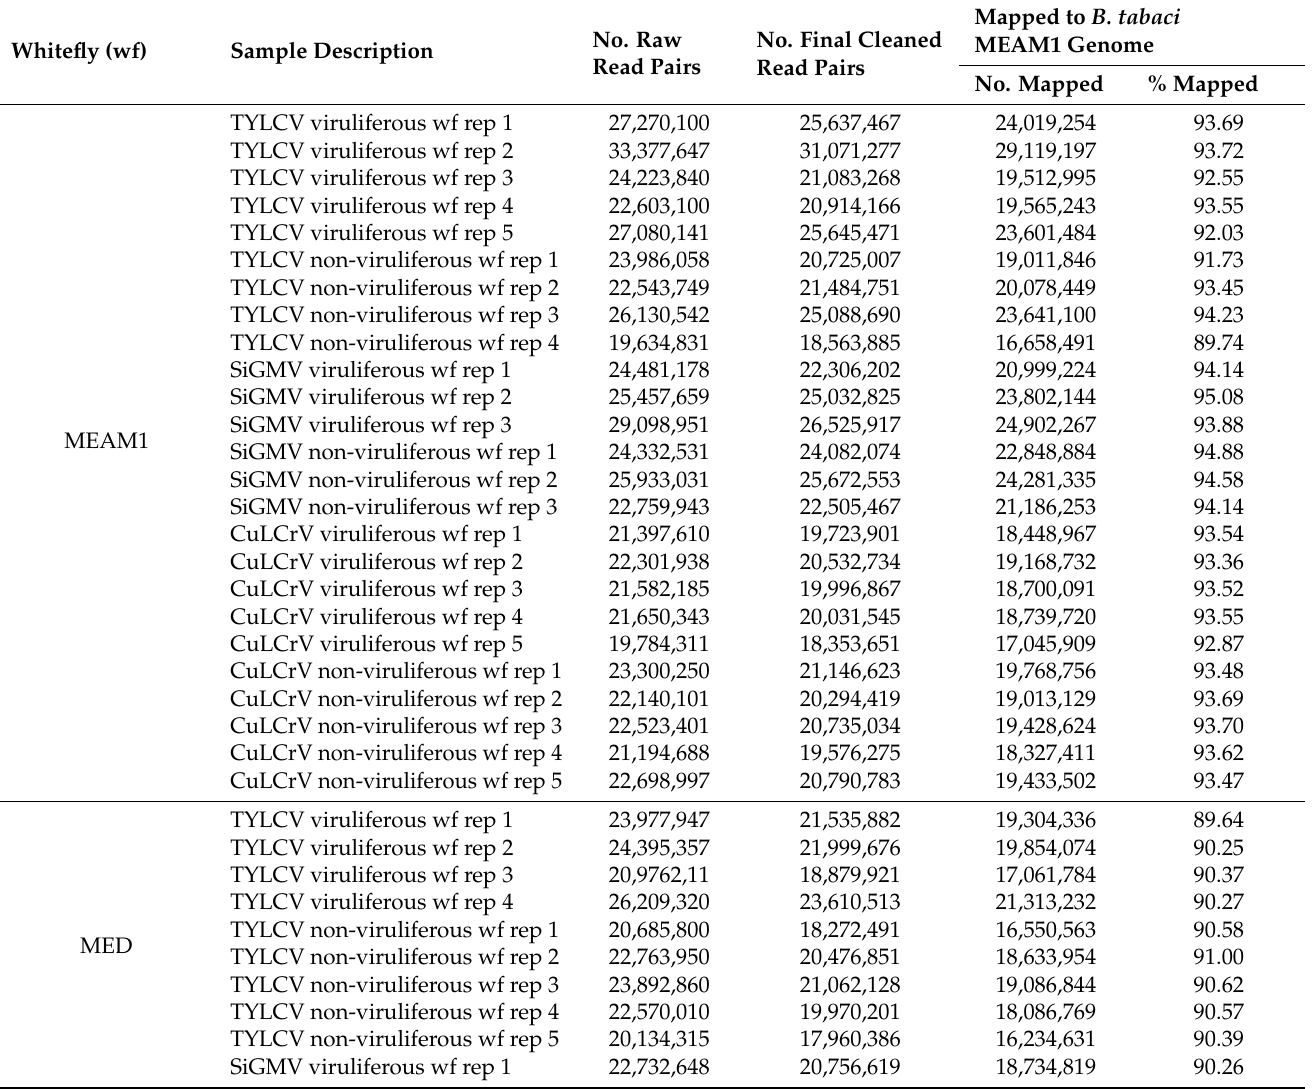
Table 1. Summary of RNA sequencing datasets generated from Bemisia tabaci MEAM1 and MED adults provided with a feeding access for 72 h on tomato yellow leaf curl virus-infected or non- infected tomato plants, sida golden mosaic virus-infected or non-infected prickly sida plants, and cucurbit leaf crumple virus-infected or non-infected squash